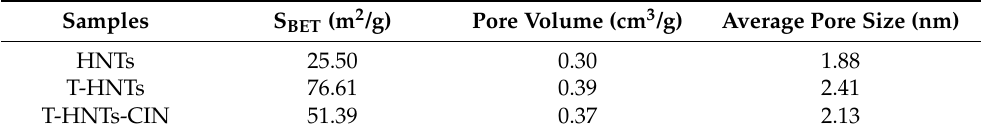
Table 1. The surface area, pore volume, and average pore size of samples.